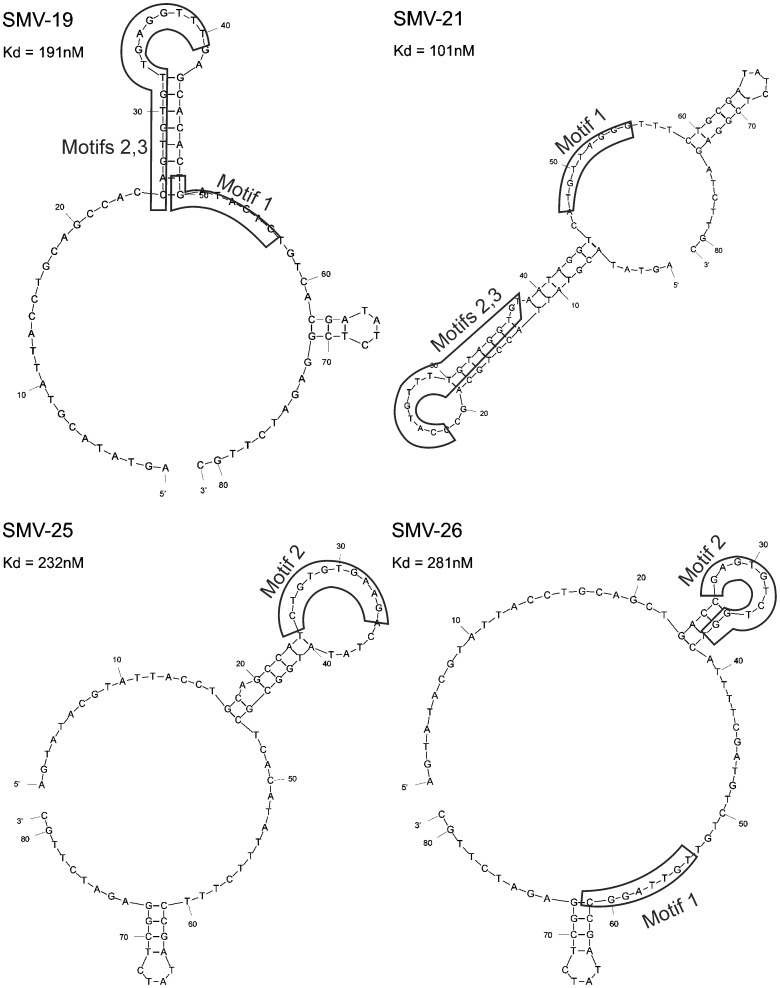
Predicted structural folding of select ssDNA aptamers for SMV.Common motifs identified in boxes.